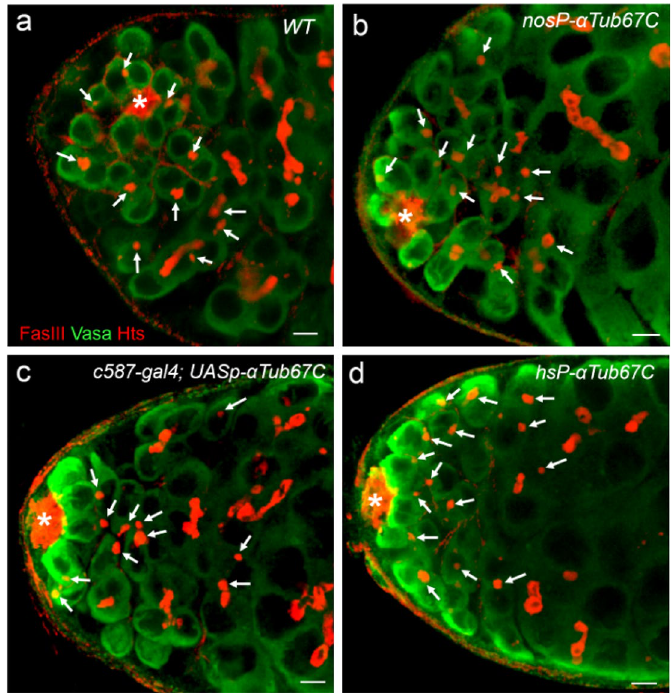
Figure 5. Overexpression of αTub67C fails to dramatically increase the number of GSC/GBs. Testes were stained with anti-Fas III antibody (red, hub with asterisk), anti-Hts antibody (red, fusomes), and anti-Vasa antibody (green, germ cells). Testes were collected from wild-type ( a ), P{ nosP-αTub67C } ( b ), and c587- gal4;UASp-αTub67C male flies ( c ). Testes were dissected from P{ hsP-αTub67C } male flies ( d ), which were cultured at 37 ℃ for 1.0 h three times per day. Spectrosomes-containing GSCs and GBs are indicated by arrows. Oregon-R was used as the wild-type flies. Scale bars: 5 μm.